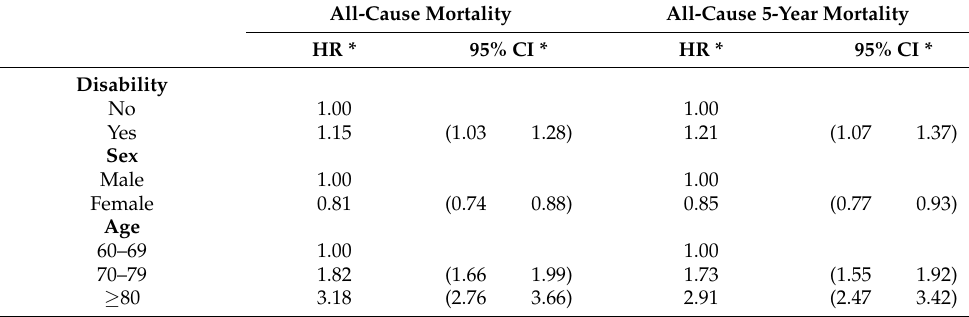
Table 2. Results of the Cox regression analysis on the association between disability status and